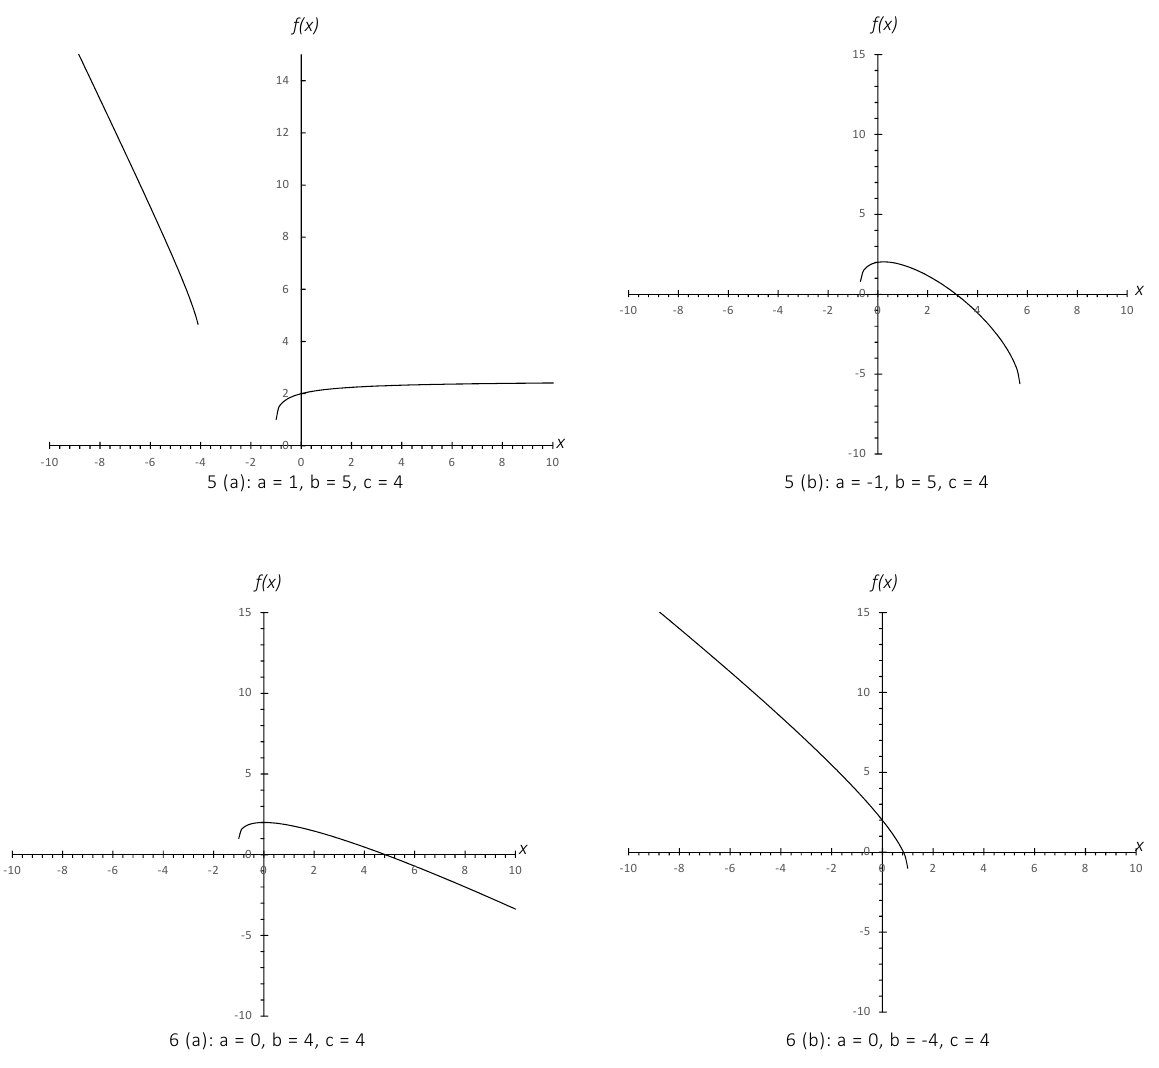
Figure A3. The graph of f ( x ) for Case 5(a) through Case 6(b) from Theorem